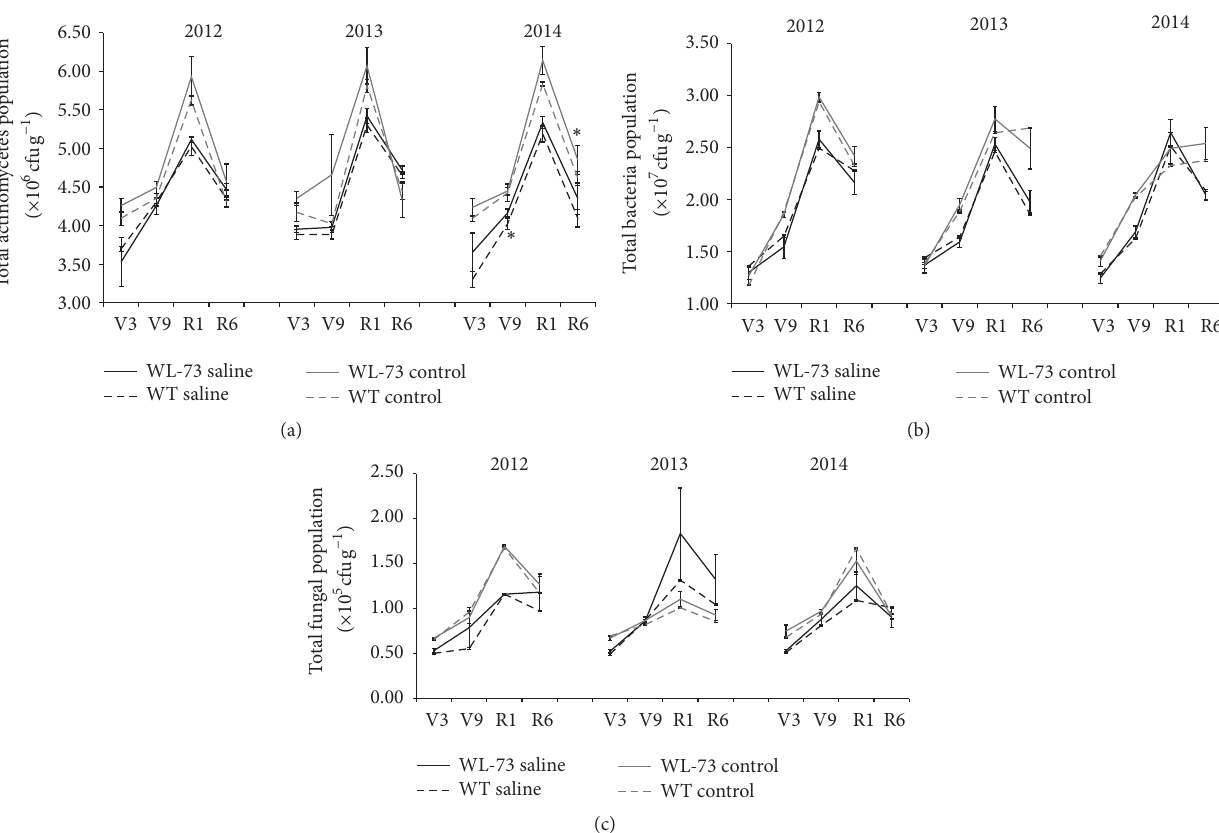
Figure 7: Assays of three microbial communities in rhizosphere soil. BcWRKY1 transgenic maize (WL-73) and nontransgenic maize (WT; LH1037) plants were grown in saline or control nonsaline soil from 2012 to 2014 ( ∗ 𝑃 < 0.05 , 𝑛 = 3 ). We investigated the microbial populations in their rhizosphere soil. (a) Actinomycete population, (b) bacterial population, and (c) fungal population in terms of cfu (colony forming units) per g of dry soil. WT, wild-type maize LH1037; WL-73, LH1037 plant transformed with BcWRKY1 ; V3, the three lowest leaves have a visible collar; V9, nine leaves have collars present; R1, silking; R6, physiological maturity. ∗ indicates a significant difference at 𝑃 < 0.05 according to the LSD test ( 𝑛 = 3 ). The standard error is based on the average of three biological replicates from 2012 to 2014. Note 1: the variation in the actinomycete, bacterial, and fungal populations was consistent. The populations of the three microbial communities increased from growth stages V3 through V9. The total number of each of the three types of microbes in the rhizosphere soil peaked at the V1 stage. Subsequently, the population levels of all three types of microorganisms decreased at the V6 stage. Note 2: to ensure consistency in the experimental data, transgenic and nontransgenic material were planted in the same pot for the three years, and each pot was handled at the same time to minimize the impact of human factors on the